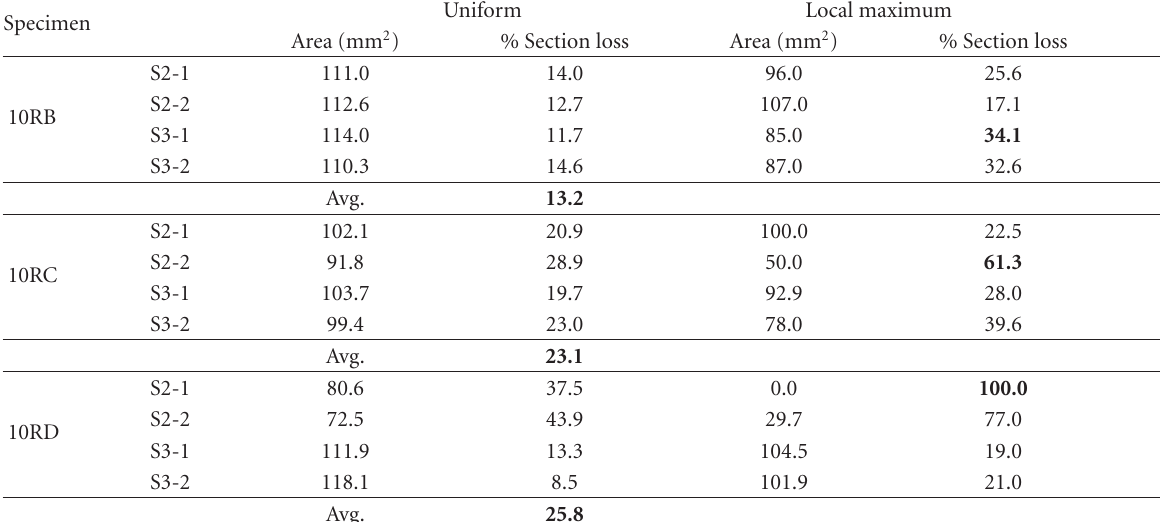
Table 2: Uniform and local maximum cross-sectional losses for experimental stirrup